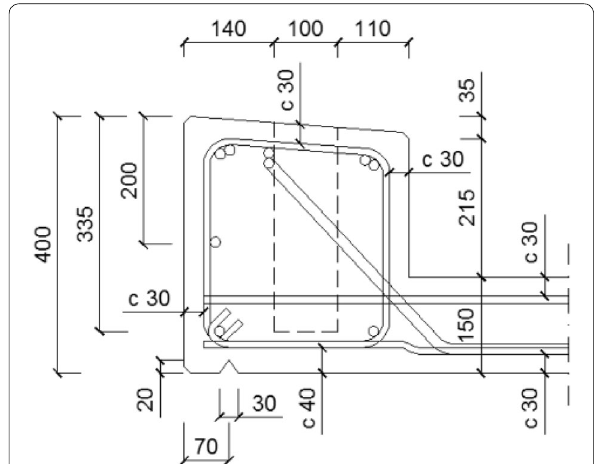
Fig. 2 Detail of edge beam from Stallbacka Bridge. Dimensions are in